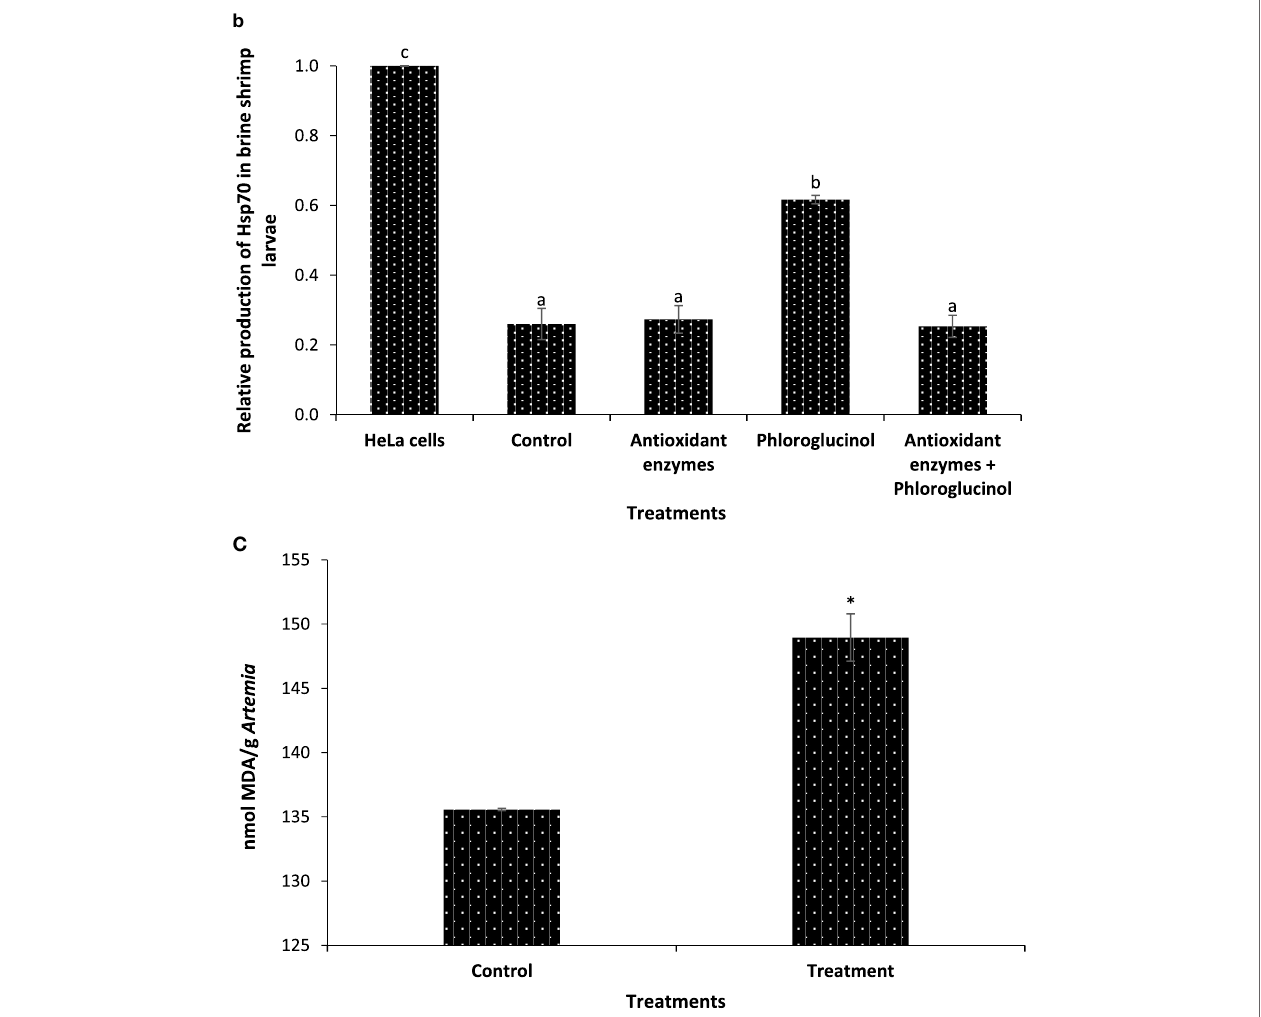
FigUre 2 | Phloroglucinol-generated prooxidant activity mediates the protective response in brine shrimp larvae. (a) Survival (%) of brine shrimp larvae pretreated with antioxidant enzymes, phloroglucinol, or in combination with both (antioxidant enzymes and phloroglucinol) after 48 h of challenge with Vibrio parahaemolyticus MO904. The larvae were pretreated with antioxidant enzymes (catalase, 10 mg/l and superoxide dismutase (SOD), 75 units), phloroglucinol (30 µM), and mixture of antioxidant enzymes and phloroglucinol for 2 h, rinsed to wash away the compound, and then allowed to recover for 2 h. The larvae were subsequently challenged with V. parahaemolyticus at 10 7 cells/ml of rearing water. Non-pretreated larvae that were either challenged with V. parahaemolyticus (positive control) and those not challenged with V. parahaemolyticus (negative control) served as controls. Error bars represent the standard error of five replicates; different letters indicate significant differences ( P < 0.001). (b) Induction of heat shock protein (Hsp70) protein in brine shrimp larvae. The brine shrimp larvae were pretreated with antioxidant enzymes, phloroglucinol, or in combination with both (antioxidant enzymes and phloroglucinol) as described in Figure 2a . Non-pretreated larvae were maintained as control. (a) Protein extracted from different treatment groups was resolved on an SDS-PAGE gel and then transferred to a polyvinylidene fluoride membrane and probed with an antibody to brine shrimp Hsp70. Molecular mass standards (M) in kilodaltons are shown on the left. The induction of Hsp70 in HeLa cells was regarded as 1. (b) Quantitative analysis of Hsp70 levels in the brine shrimp larvae is presented relative to Hsp70 production in HeLa cells. Error bars represent the standard error of three replicates; different letters indicate significant differences ( P < 0.001). (c) Effect of phloroglucinol on lipid peroxidation in brine shrimp larvae. Lipid peroxidation is expressed as malondialdehyde (MDA) content in each sample. The larvae were pretreated with phloroglucinol (30 µM) for 2 h, rinsed to wash away the compound, and then allowed to recover for 2 h. The larvae were subsequently collected and analyzed for MDA/g of Artemia . Non- pretreated larvae were maintained as control. Error bars represent the standard error of two independent samples; asterisks represent significant difference between the control and the treatment, * P <